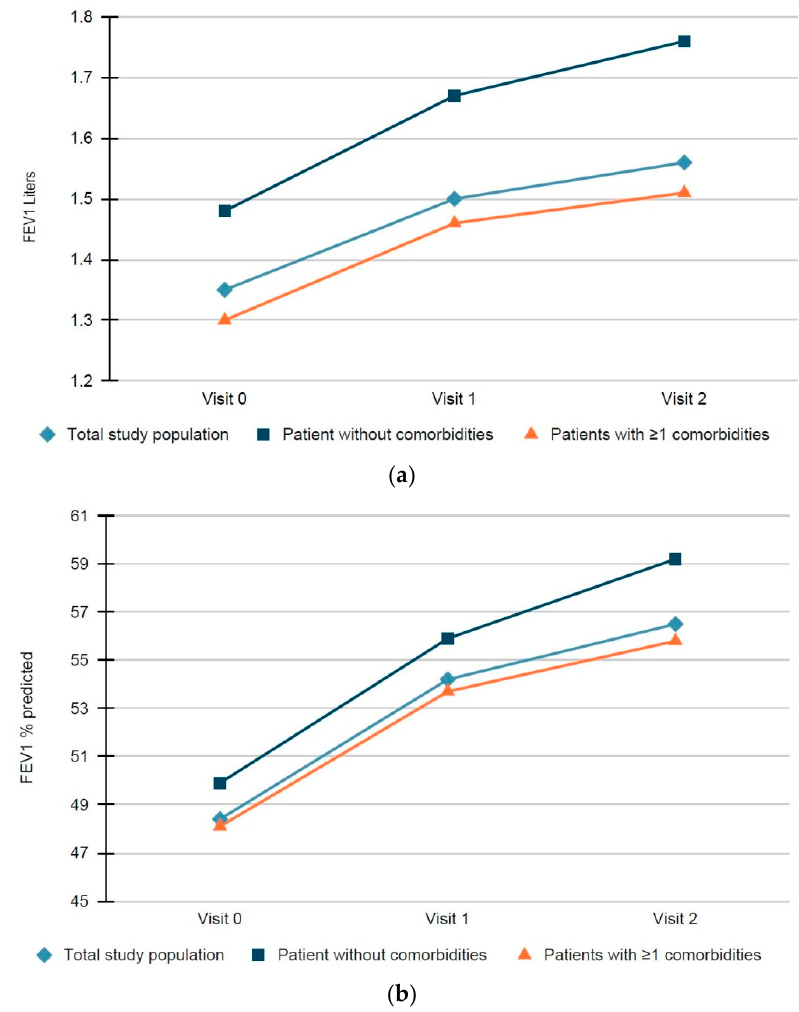
Figure 2. ( a ) FEV 1 (Liters) per visit in total study population, patients without comorbidities and with ≥ 1 comorbidities; ( b ) FEV 1 % predicted per visit in total study population, patients without comorbidities and with ≥ 1 comorbidities.